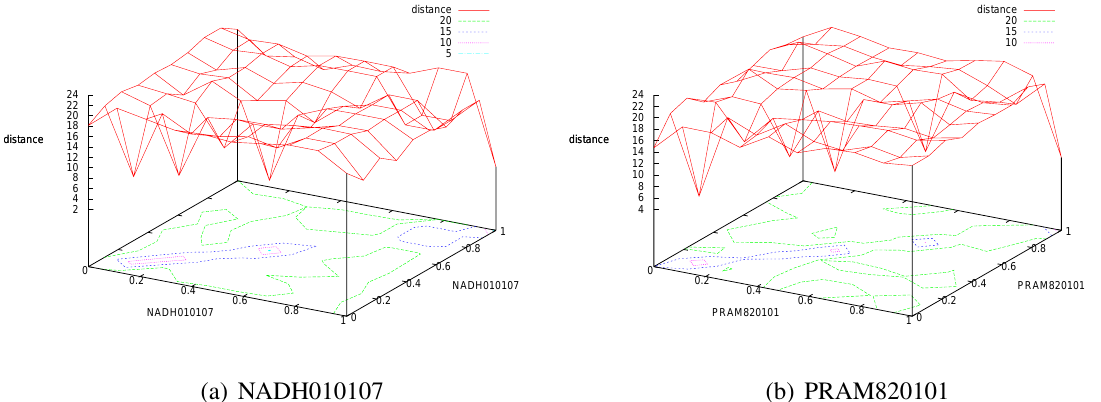
Figure 7: Pattern type: “valley surfaces”. The 3D surface represents the mean distances among pairs of amino acids according to properties (a) NADH010107 and (b)